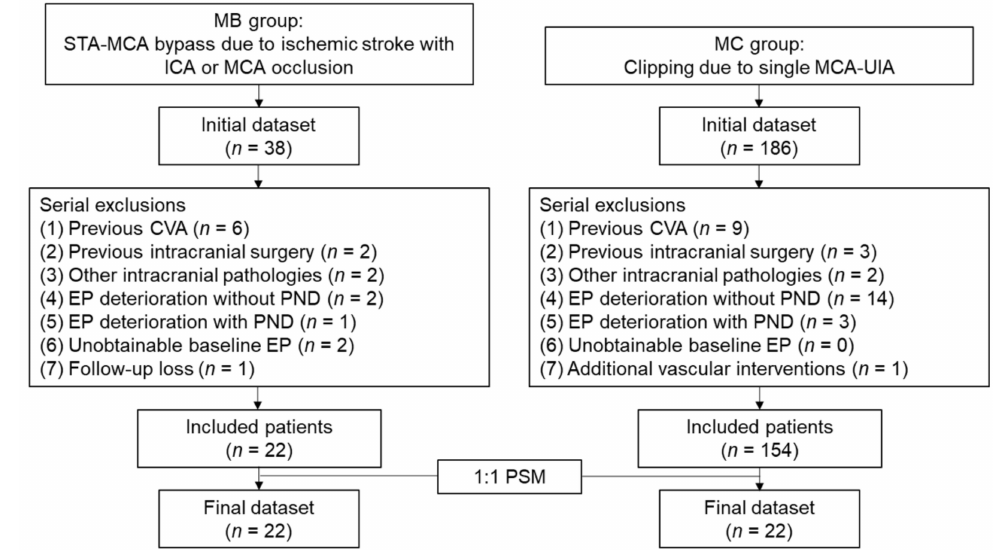
Figure 1. Flowchart of patient enrollment. MB, middle cerebral artery bypass surgery; MC, middle cerebral artery clipping surgery; STA, superficial temporal artery; MCA, middle cerebral artery; ICA, internal carotid artery; EP, evoked potential; PND, postoperative neurologic deficit; PSM, propensity score